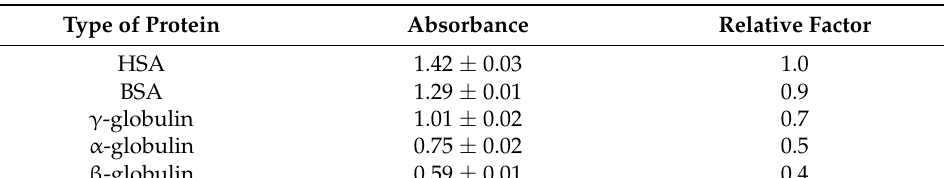
Table 2. Absorbance and relative response of the Bradford reaction towards each protein. Solution at c = 1 g/dL.